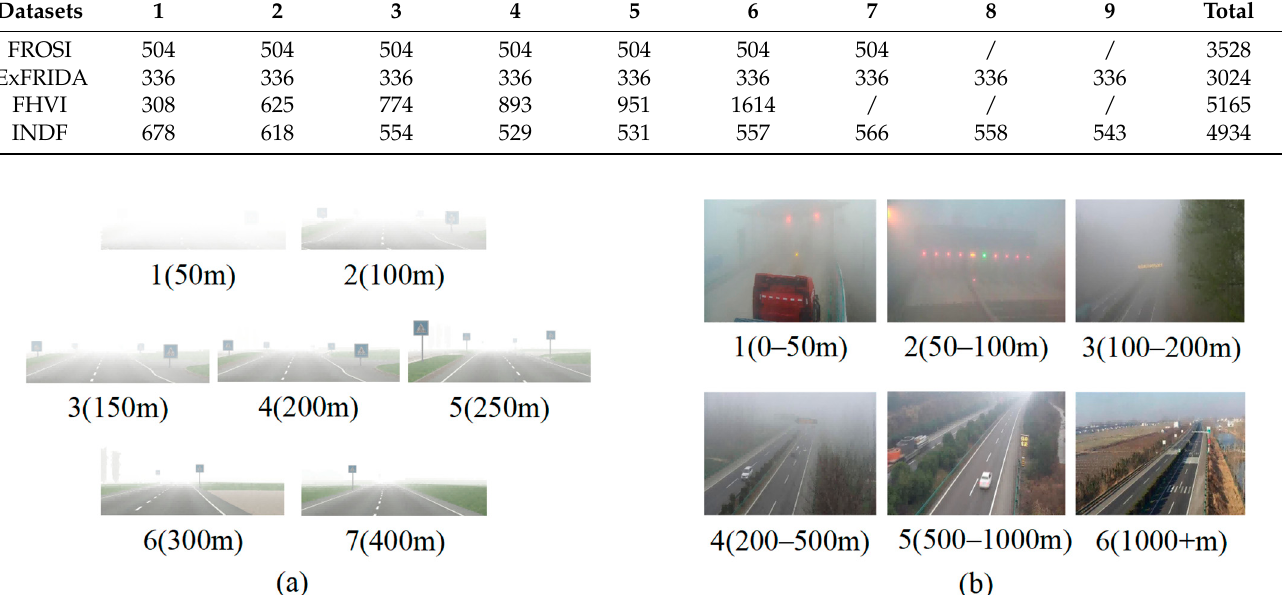
Figure 6. Images from the synthetic FROSI dataset with 7 haze levels ( a ), from the real FHVI dataset with 6 haze levels ( b ), from the ExFRIDA dataset with 9 haze levels ( c ), and from the INDF dataset with 9 haze levels ( d ).